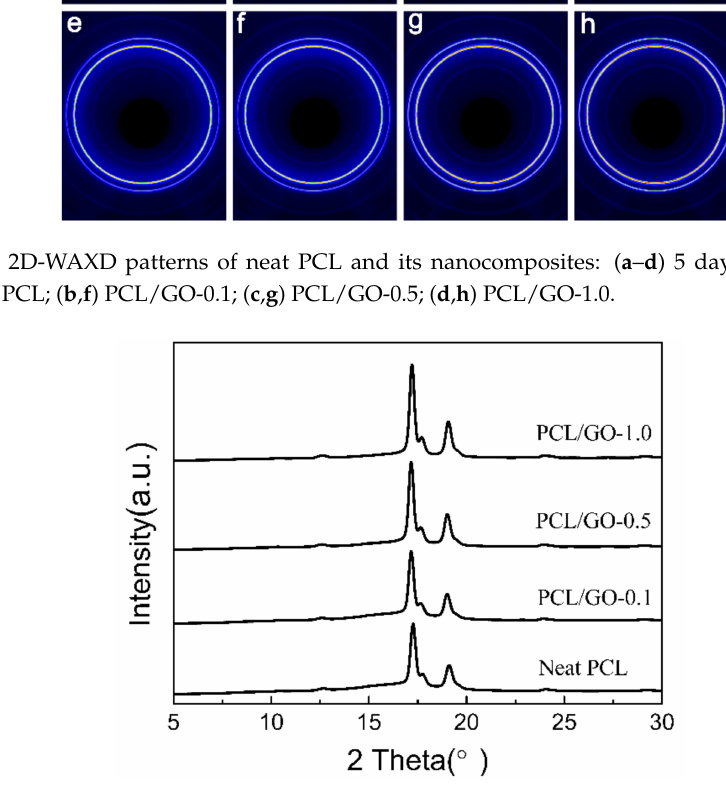
Figure 4. WAXD curves of neat PCL and its nanocomposites collected from the corresponding 2D-WAXD patterns after leaving 50